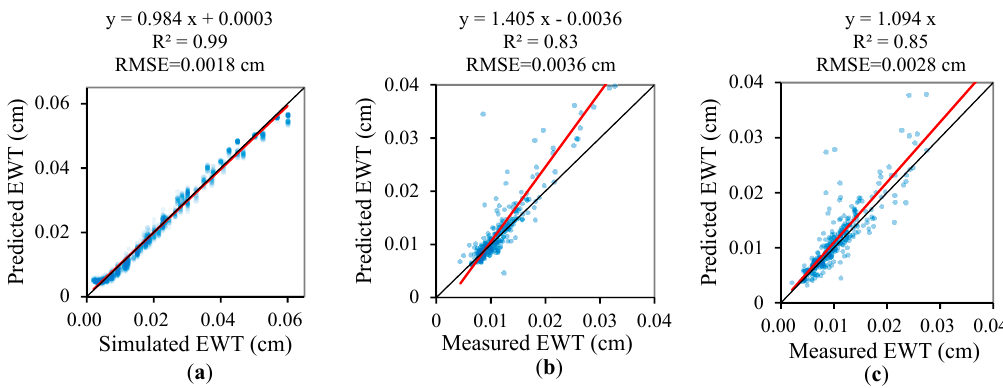
Figure 8. The results of the validation of the equivalent water thickness (EWT) model based on the principal component analysis (PCA) method obtained using the simulated ( a ), ANGERS ( b ) and LOPEX’93 datasets ( c ). RMSE is the root mean squared error computed based on the EWT model as in Equation (7); R 2 is the determination coefficient.